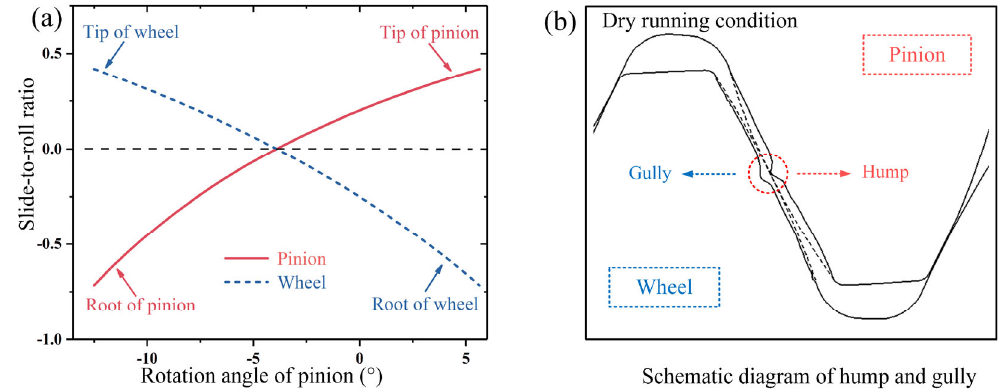
(a) Slide-to-roll ratio and (b) schematic diagram of polyformaldehyde gear pair.